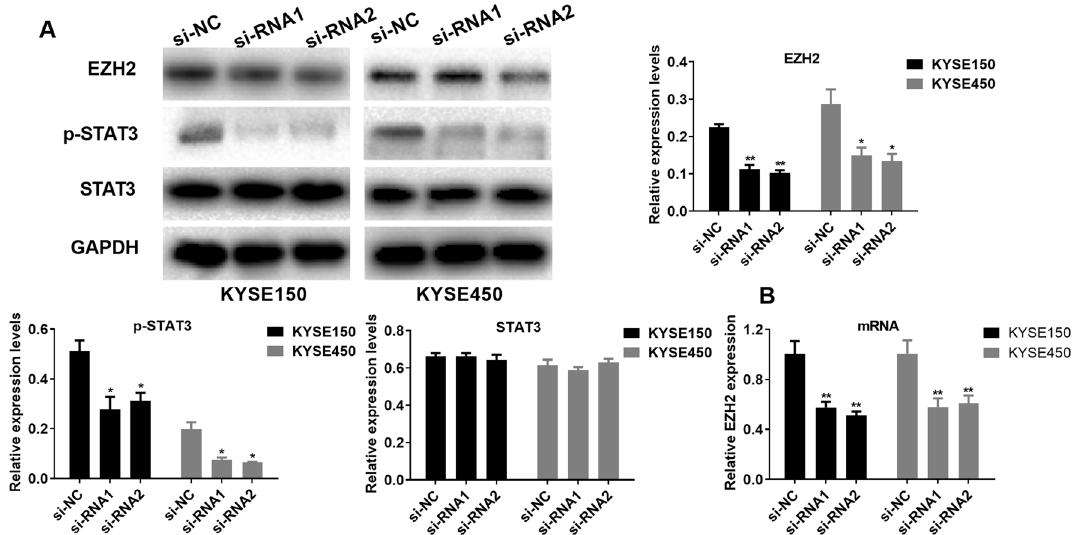
Figure 3. SNHG6 regulates the EZH2/STAT3 pathway in EC cells. ( A ) Role of si-RNAs transfection in protein levels of EZH2, p-STAT3 and STAT3. ( B ) Role of si-RNAs transfection in mRNA levels of EZH2. *P <